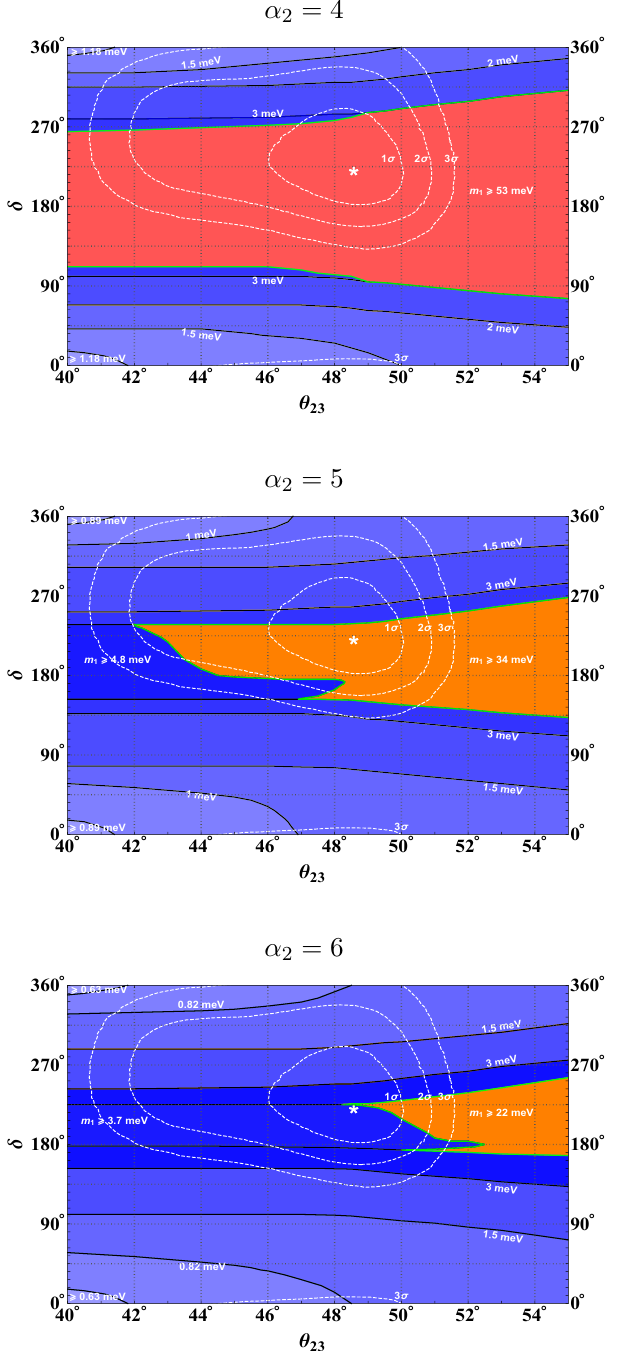
Figure 3 . Isocontour lines for the lower bound on the lightest neutrino mass in the plane ( (cid:18) 23 ; (cid:14) ) (same conventions as in (cid:12)gure 2) for (cid:11) 2 = 4 (top panel), (cid:11) 2 = 5 (central panel) and (cid:11) 2 = 6 (bottom panel).